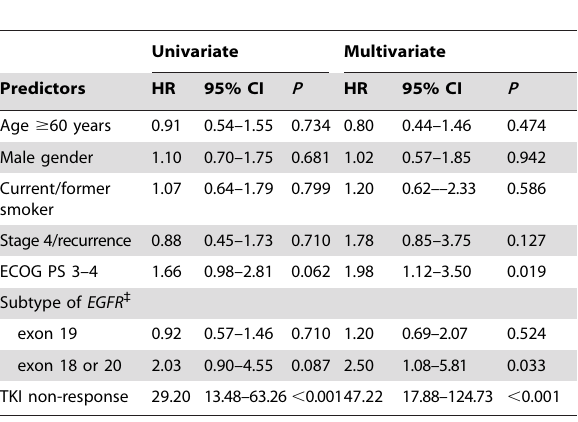
Table 2. Analysis of clinical variables associated with progression free survival in NSCLC EGFR -mutant patients.